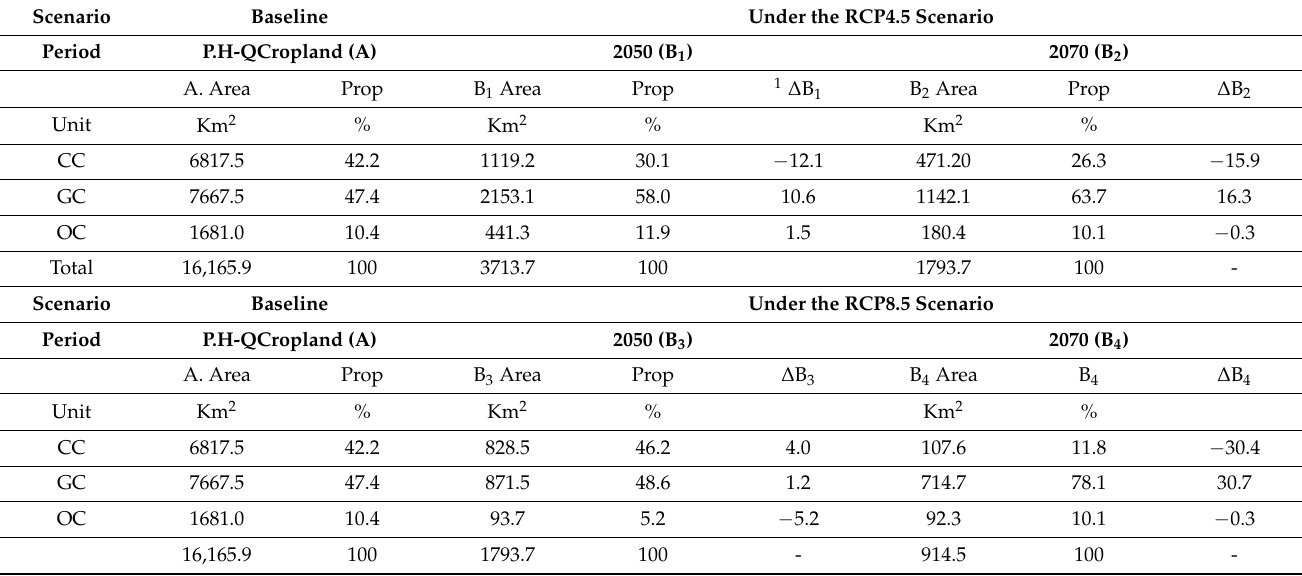
Figure 5. Spatial distribution on RCP scenario: ( a ) RCP4.5 scenarios in 2050s and 2070s; ( b ) RCP 8.5 scenario in 2050s and 2070s. Table 4. Land use shares of potential high-quality (H-Q) cropland by different scenarios.